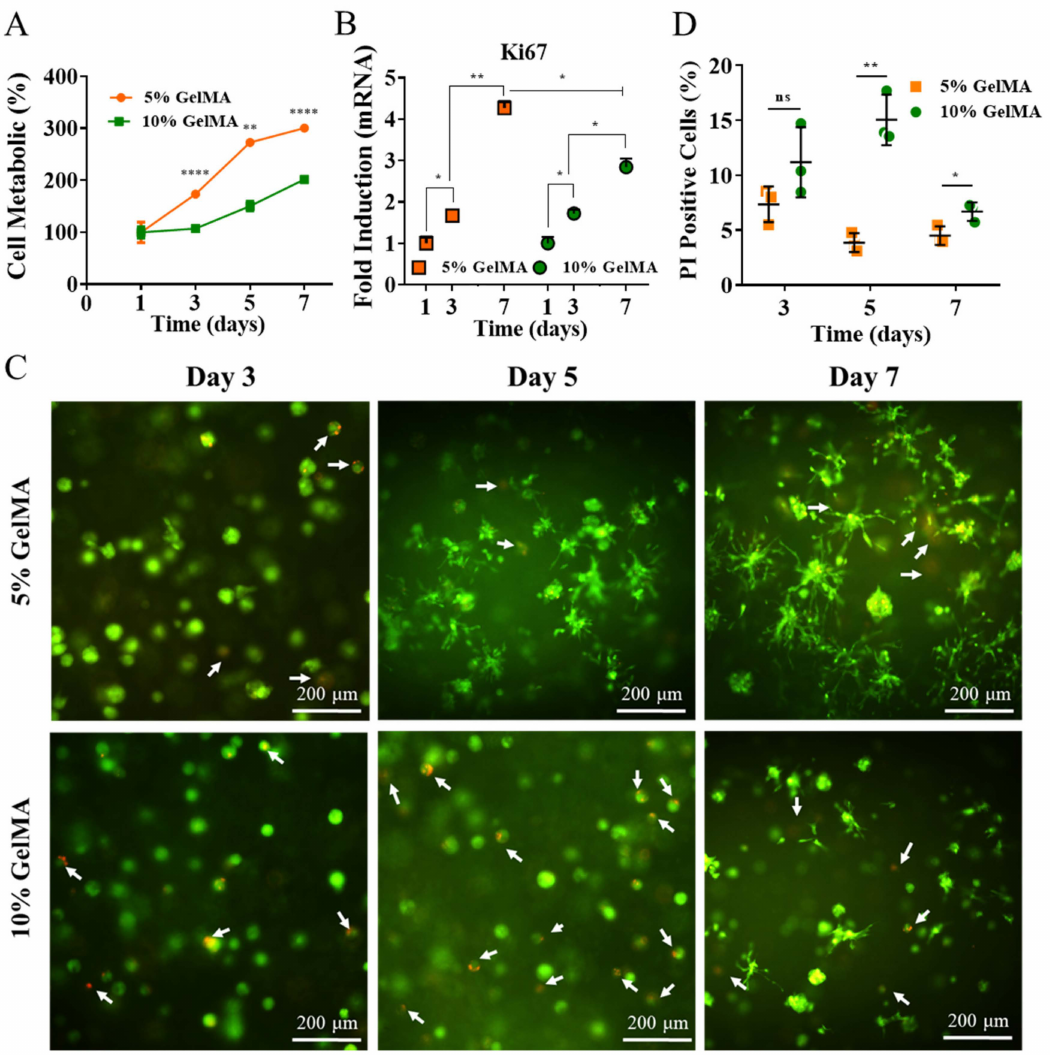
Figure 2. SCs proliferation and viability in 5% and 10% GelMA. ( A ) CCK-8 result of SCs in 5% and 10% GelMA on day 1, 3, 5, and 7. ( B ) qPCR result of ki67 expression of SCs in 5% and 10% GelMA on day 1, 3, and 7. ( C ) Statistical cell viability. Quantification of PI-positive cells (dead cells). ( D ) Live/Dead assay by calcein-AM and PI staining on day 3, 5, and 7. Living cells are depicted in green, and dead cells are in red. (Scale bar: 200 µ m). * p < 0.05, ** p < 0.01, **** p <